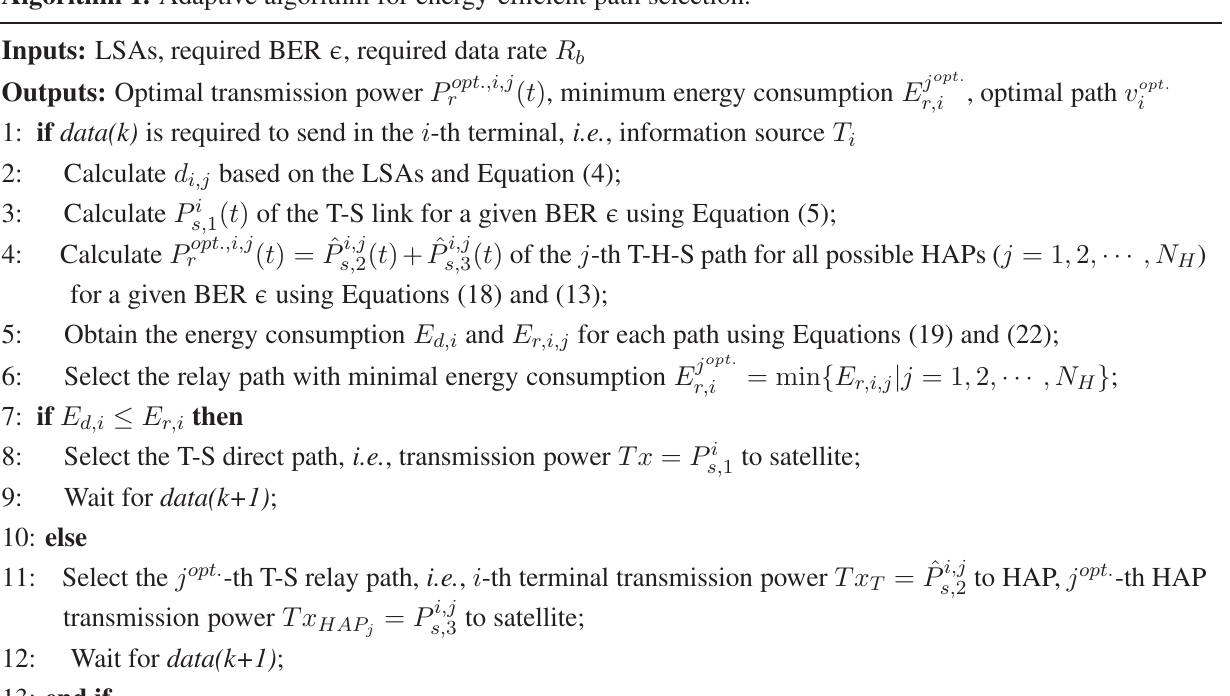
Algorithm 1. Adaptive algorithm for energy-efficient path